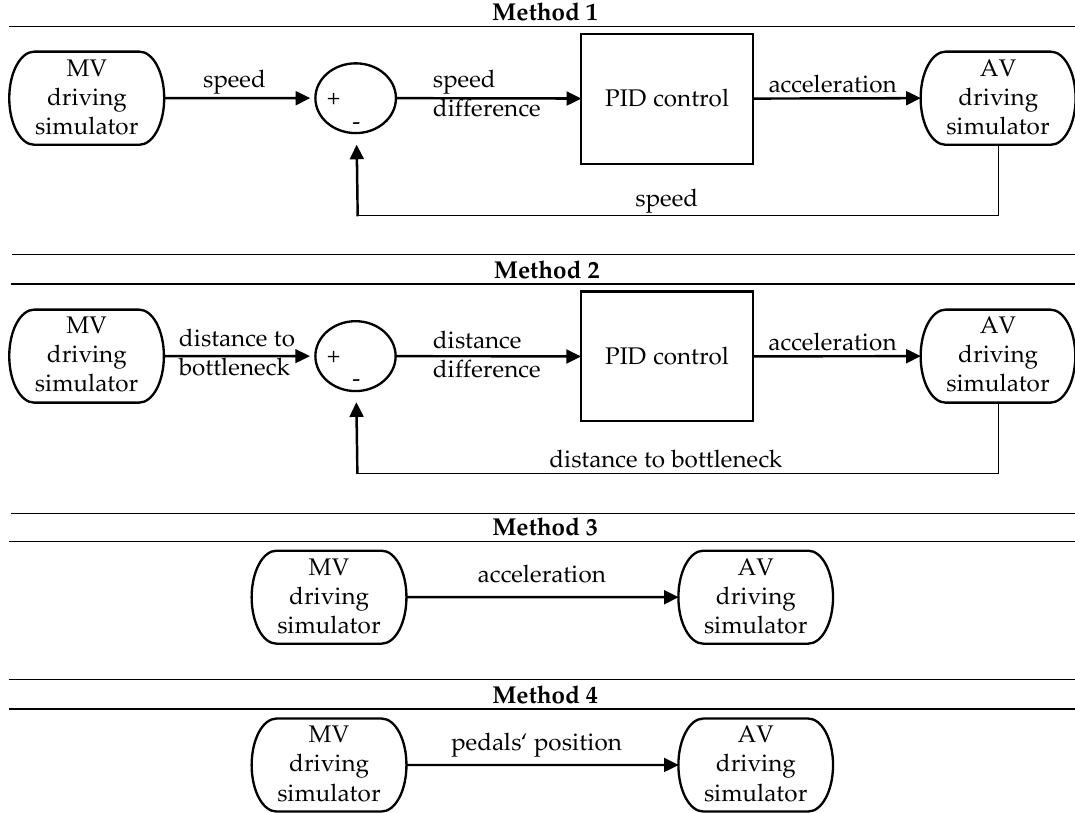
Figure 2. Block diagrams of the proposed methods to adapt the AV to the behavior of the manual vehicle (MV).